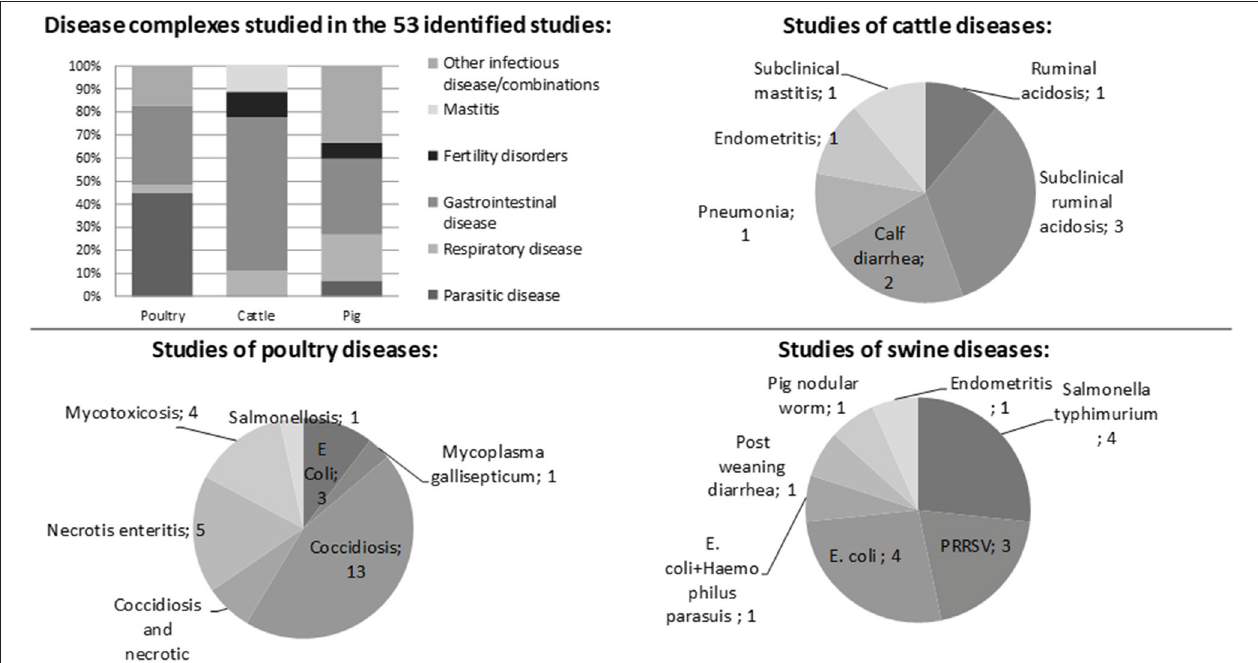
FIGURE 2 | Diseases studied in the 53 identified